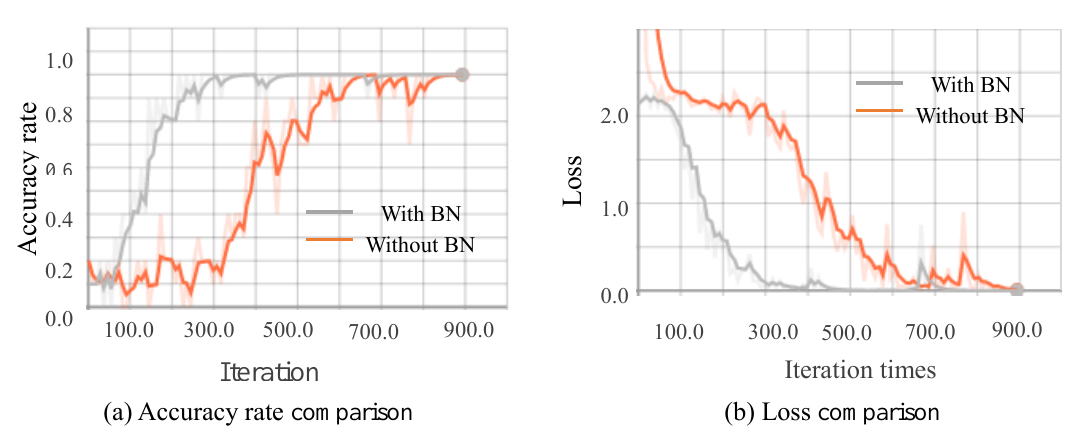
Figure 12. Comparison curves for the gray image.